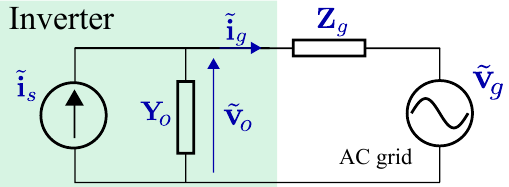
Figure 1. Equivalent small-signal model of a grid-connected inverter with dq frame